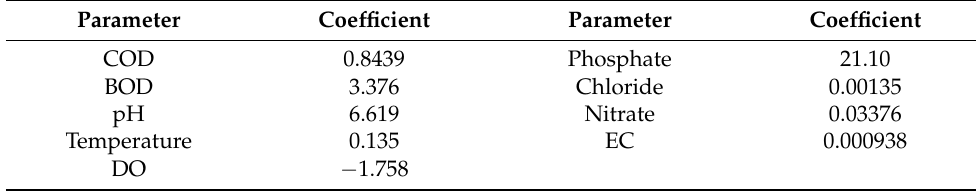
Table 4. Coefficients for the water quality index parameters.